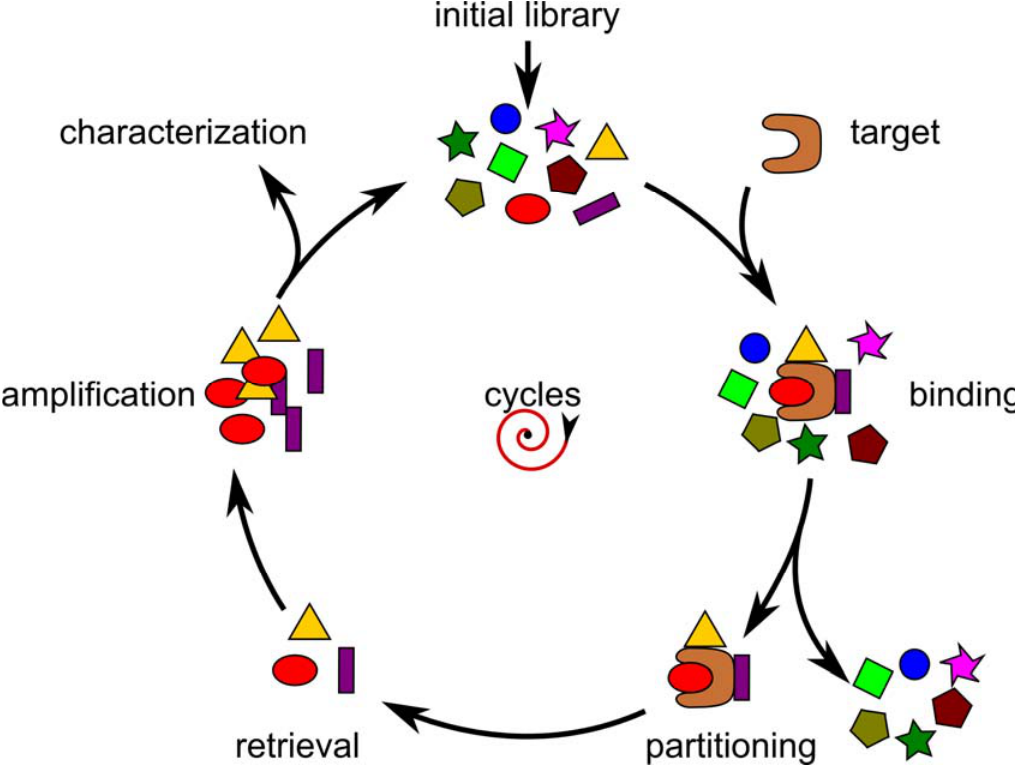
Figure 2. General selection scheme for random combinatorial